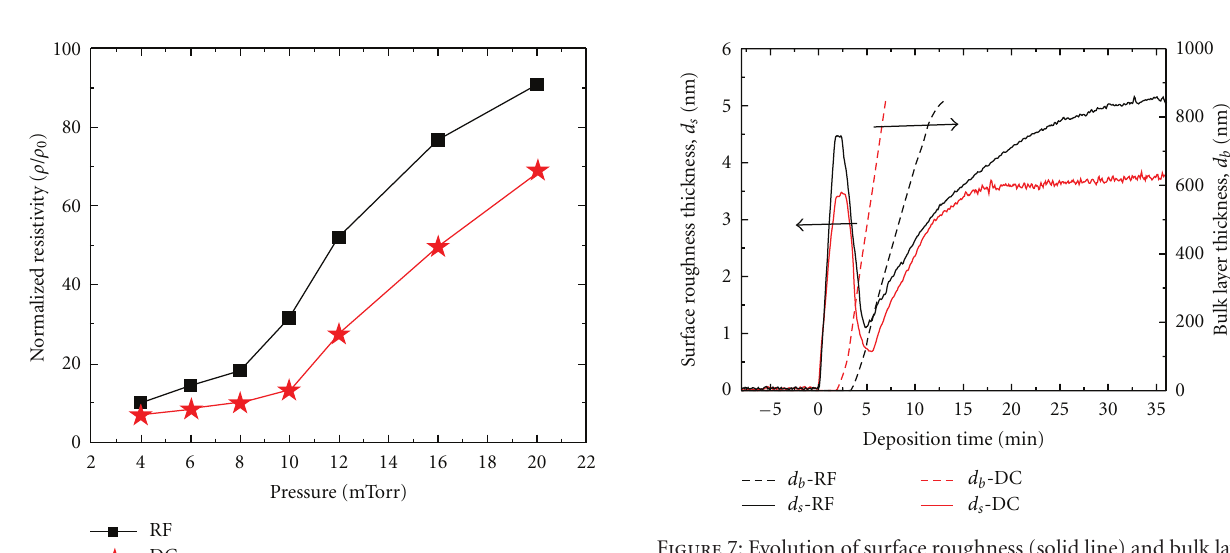
Figure 7: Evolution of surface roughness (solid line) and bulk layer thicknesses (dashed line) obtained by RTSE for Mo deposition using dc and rf sputtering at 10mTorr. The bulk layer becomes fully opaque at large thickness values and, as a result, its thickness cannot be